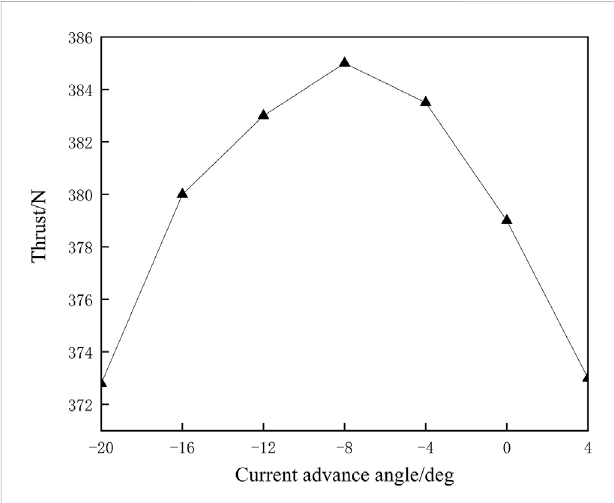
FIGURE 9 In fl uence of primary pole arc coef fi cient on thrust and regulating amplitude.